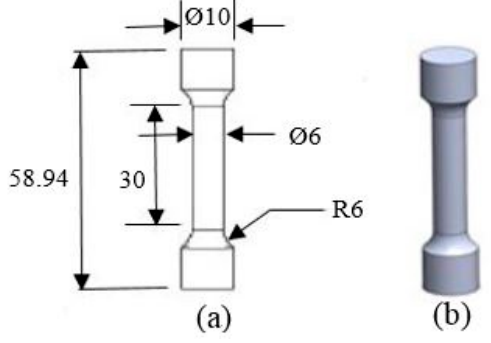
Figure 1. Specimen dimensions ( a ); and CAD file ( b )